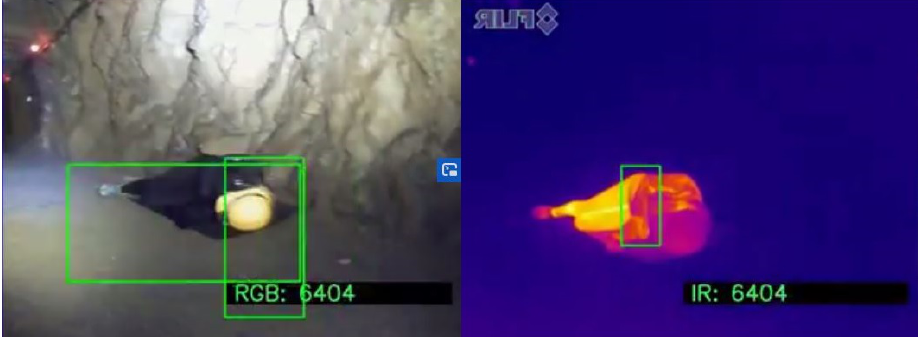
Figure 21. Human lying—correct (doubled) detection in RGB image, incomplete detection in IR image with algorithm HOG.